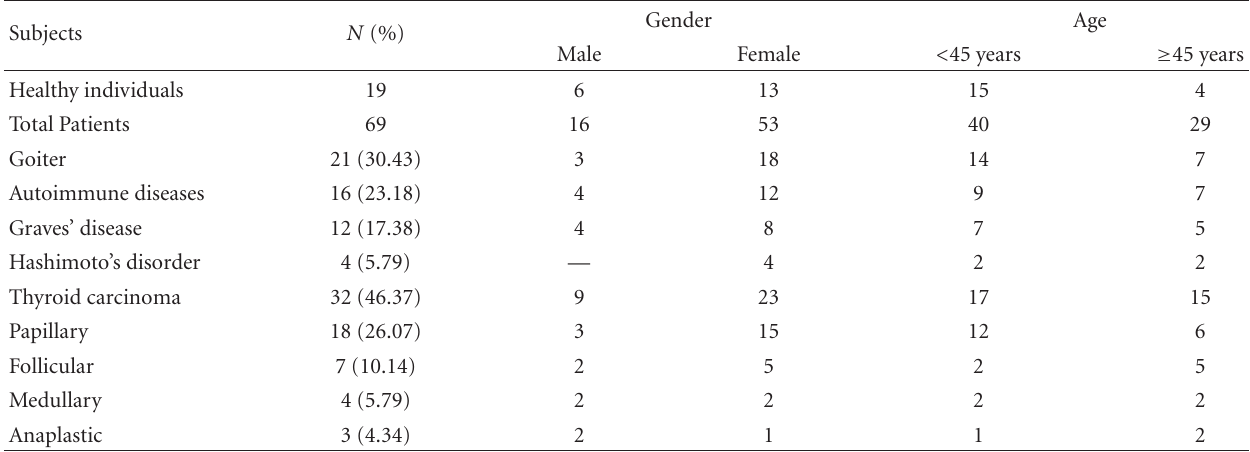
Table 1: Characterization of patients with thyroid diseases and healthy